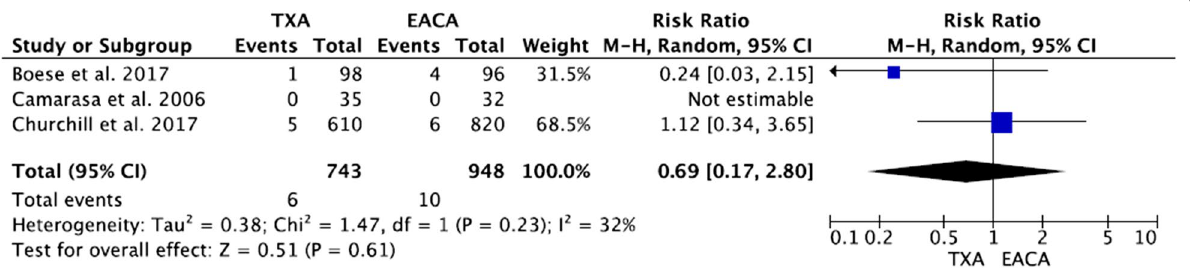
Fig. 8 Percentage of patients with VTE